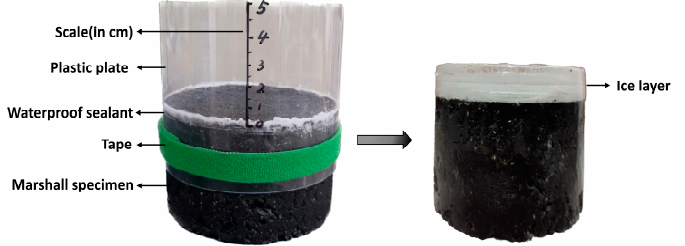
Figure 10. The preparation of the ice layer.